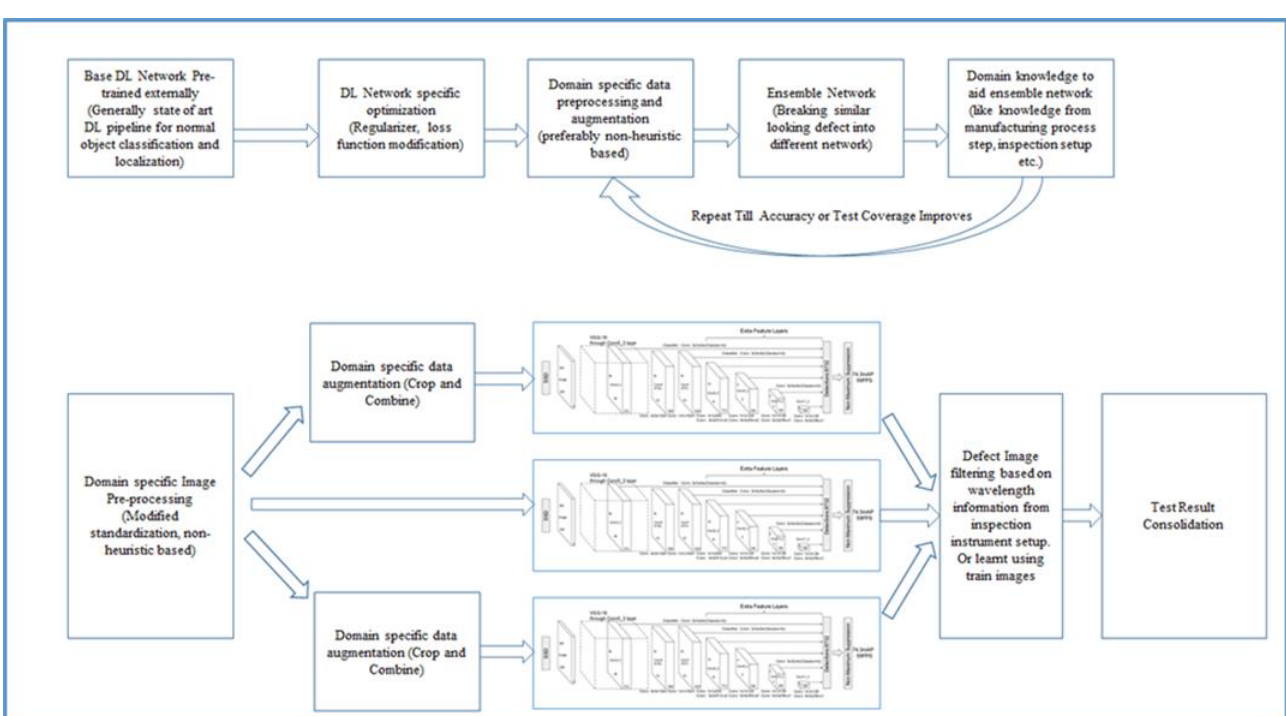
Figure 5. Depicting the general optmization strategy followed in this paper (top). Final DL Network used for MURA dataset